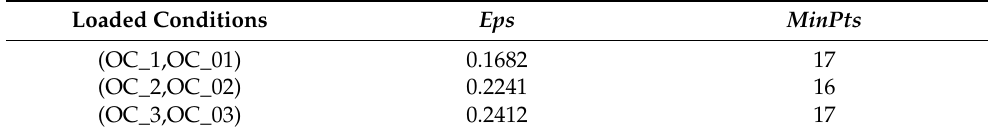
Figure 15. Clustering parameter optimization curve diagram under various loading conditions. Table 4. Cluster analysis optimal parameter